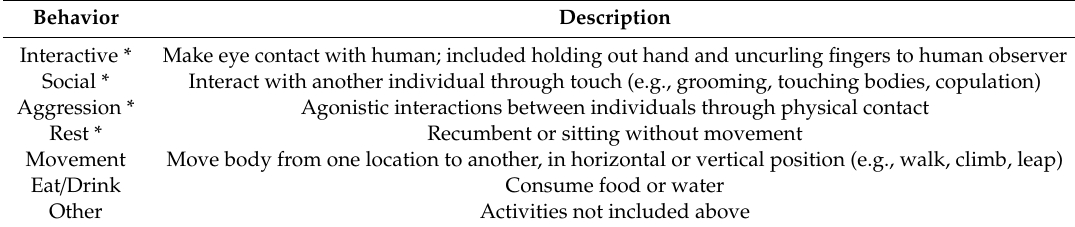
Table A9. Orangutan ethogram, with behaviors of focus indicated with an asterisk